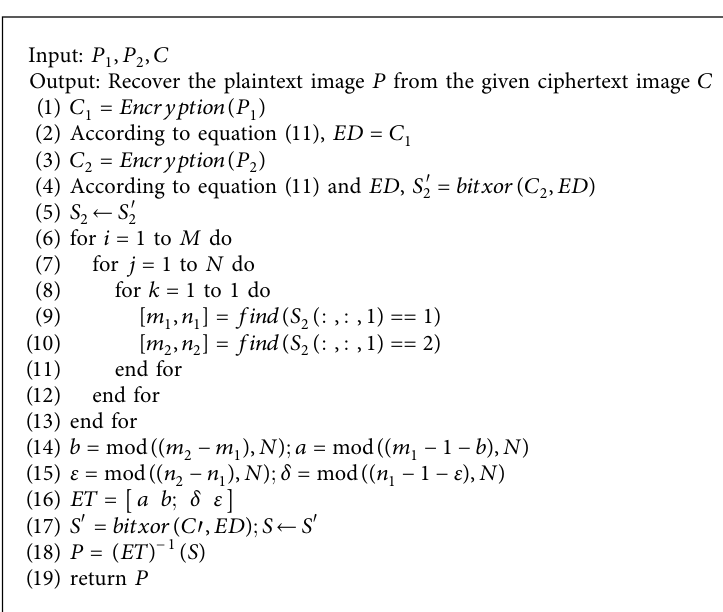
and its corresponding ciphertext image C 1